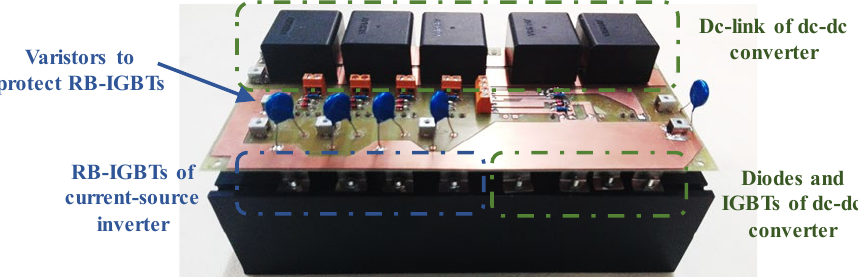
Figure 9. Final prototype of the dc-dc converter and single-phase current-source inverter fixed to heatsink.